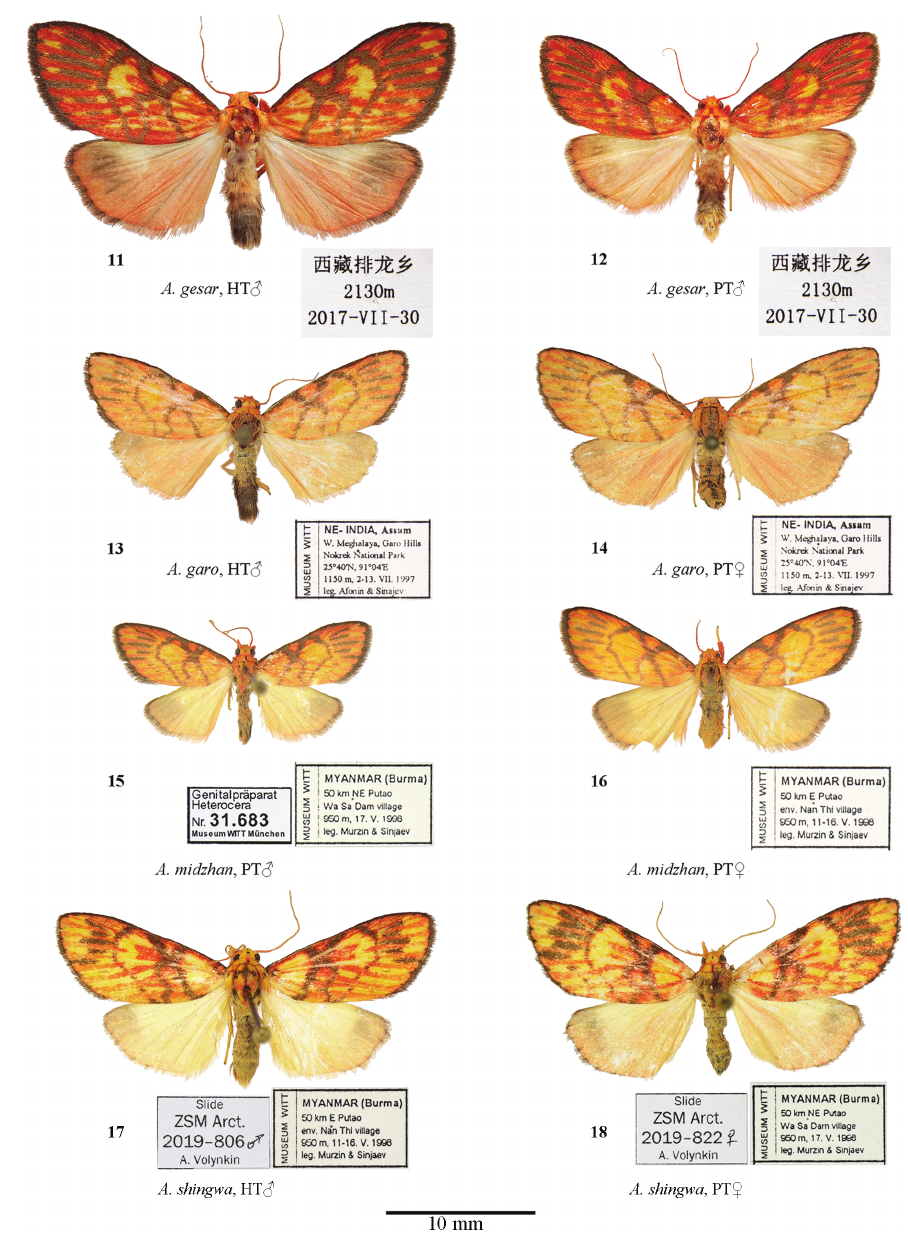
Figure 11–18. Adults of Ammathella 11 holotype of A. gesar , male, SW China (SCAU) 12 paratype of A. gesar , male, SW China (SCAU) 13 holotype of A. garo , male, MWM 31769, NE India (MWM/ZSM) 14 paratype of A. garo , female, MWM 31770, NE India (MWM/ZSM) 15 holotype of A. midzhan , male, MWM 31683, N Myanmar (MWM/ZSM) 16 paratype of A. midzhan , female, MWM 31768, N Myan- mar (MWM/ZSM) 17 holotype of A. shingwa , male, ZSM Arct. 2019-806 Volynkin, N Myanmar (MWM/ ZSM) 18 paratype of A. shingwa , male, ZSM Arct. 2019-822 Volynkin, N Myanmar